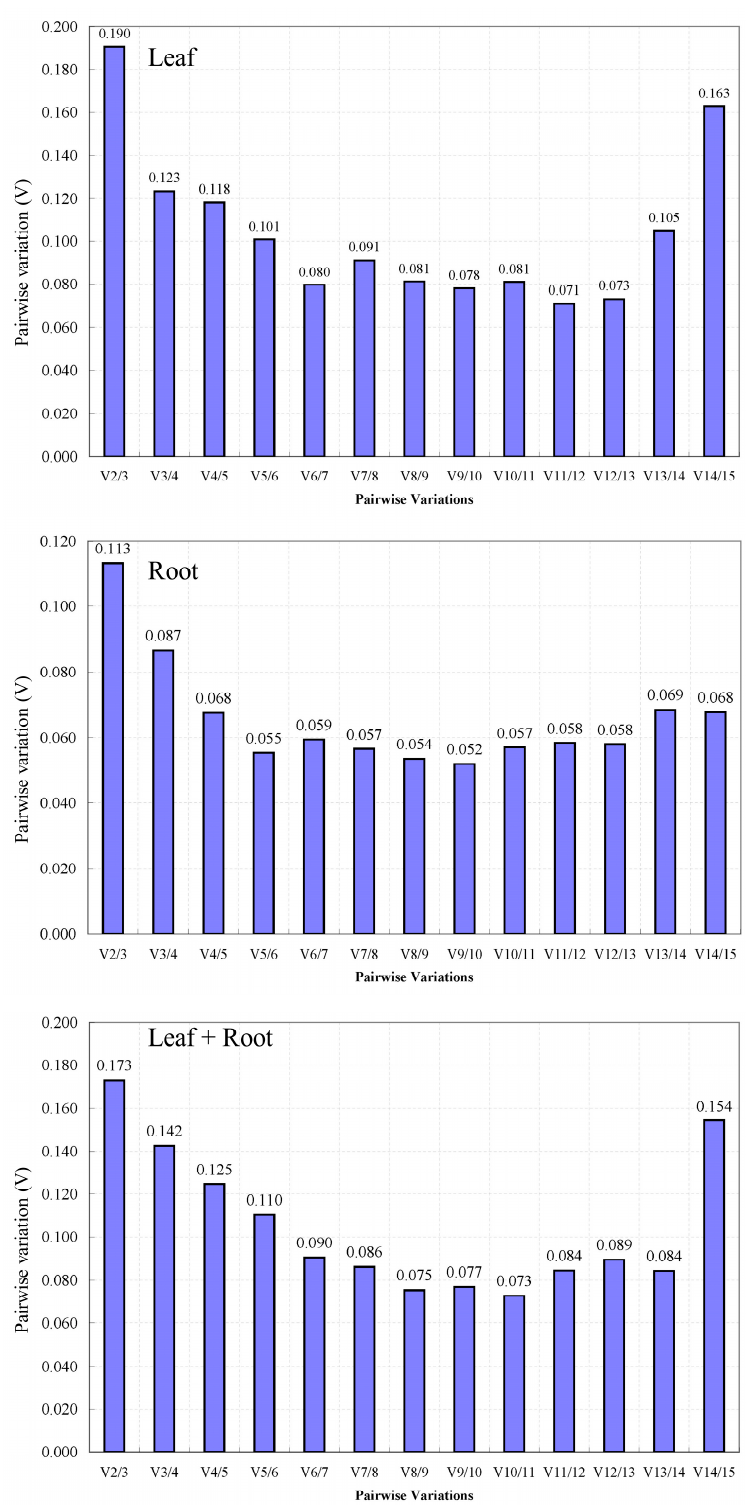
Figure 5. Determination of the optimal number of reference genes for each type of different habitat through geNorm analysis. Pairwise variation (V) was calculated by geNorm to determine the required number of reference genes for accurate normalization under different habitats. geNorm calculates pairwise variation (Vn/Vn + 1) for the normalization factors NFn and NFn + 1 to determine (V < 0.15) the optimal number of reference